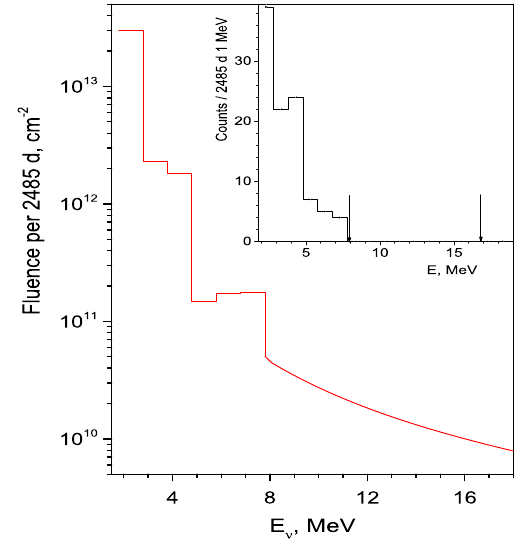
Fig. 10 90% C.L. upper limits on the ¯ ν e fluence obtained with the SN neutrino spectrum with respect to the mean neutrino energy (cid:10) E (cid:11) . The bold point shows the IceCube result [20]. The inset shows the neutrino spectrum for (cid:10) E (cid:11) = 15 . 6 MeV (1) and expected Borexino spectrum (2). Arrows mark the analysis interval